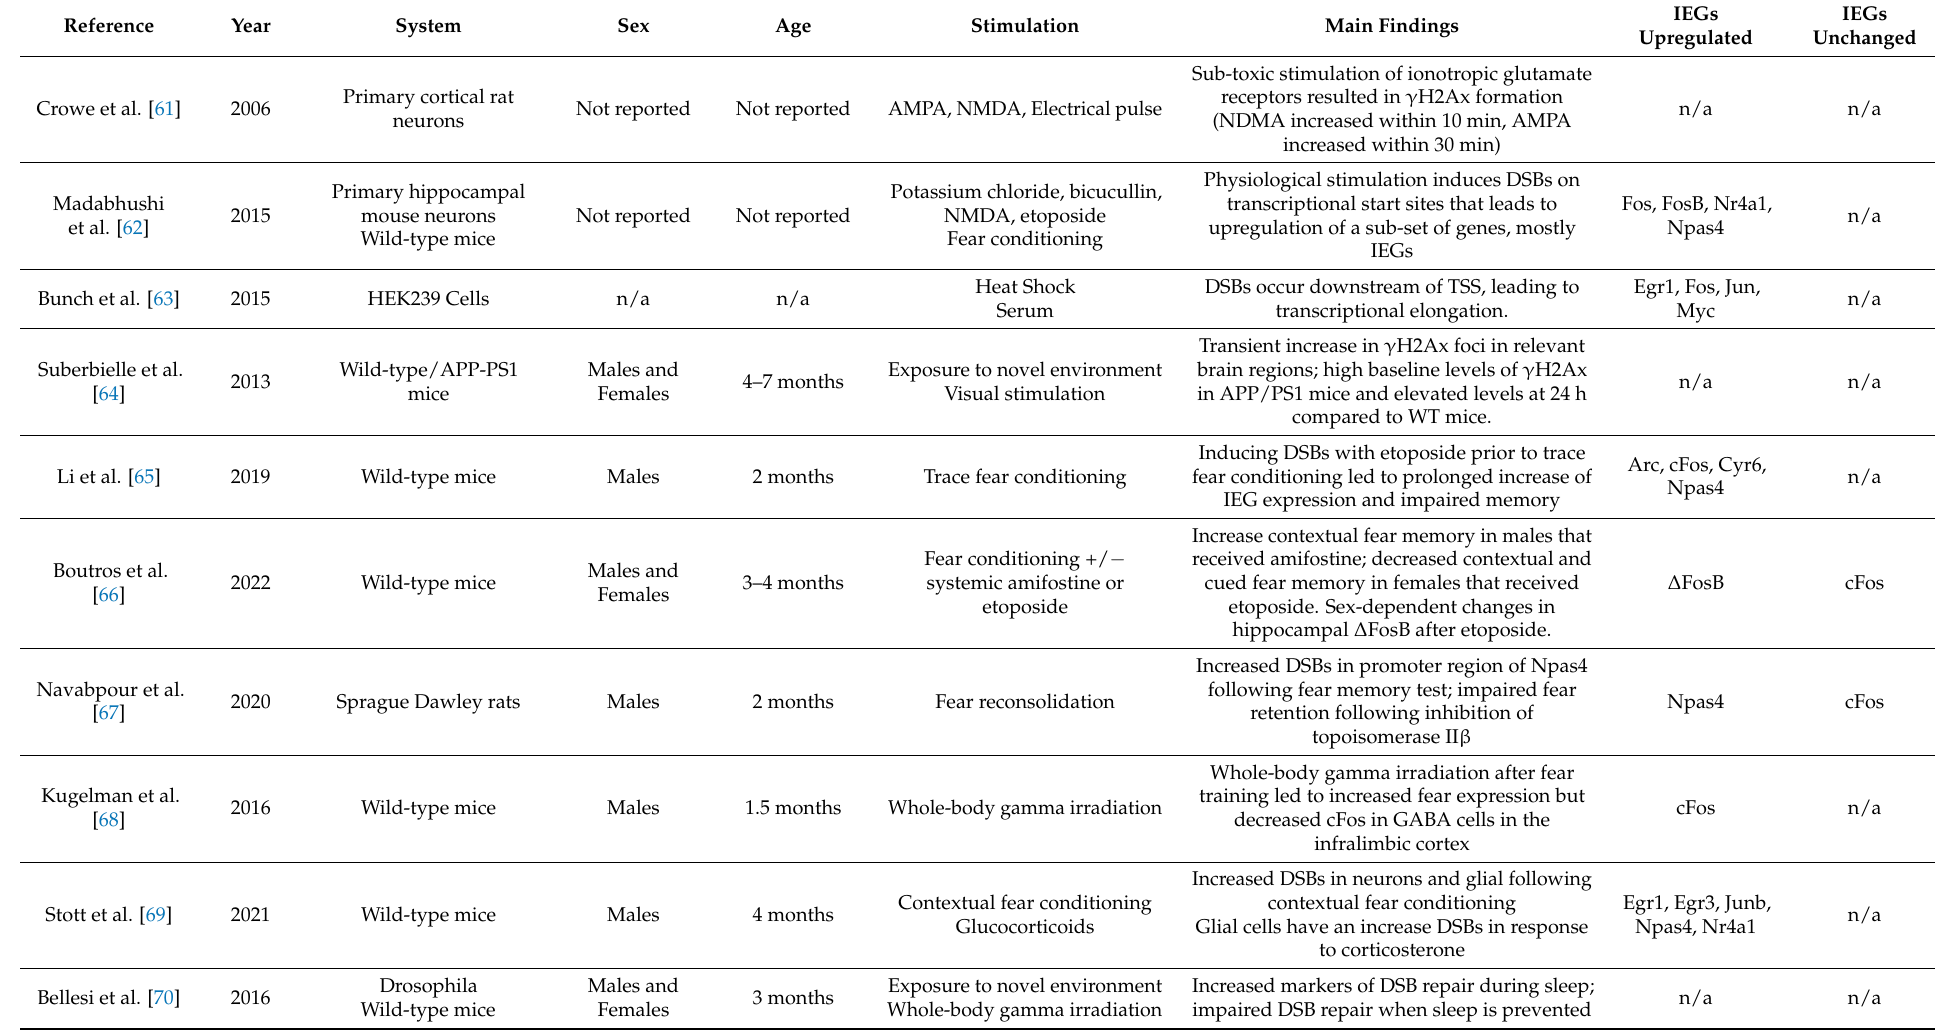
Table 2. Summary of findings related to an adaptive role of DSBs in IEG